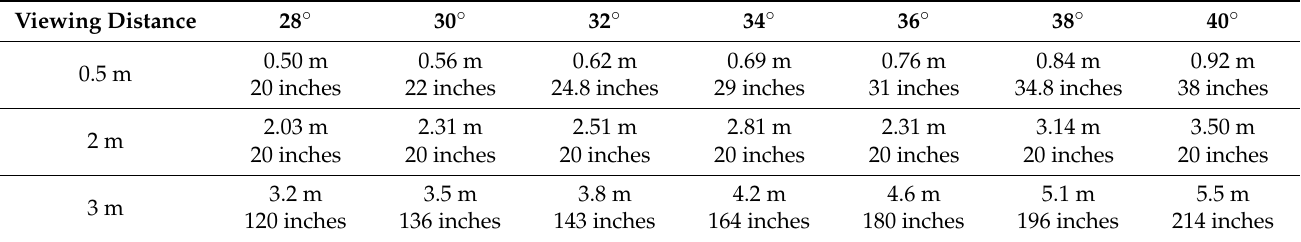
Table 4. Full diagonal for half-field viewing equivalent